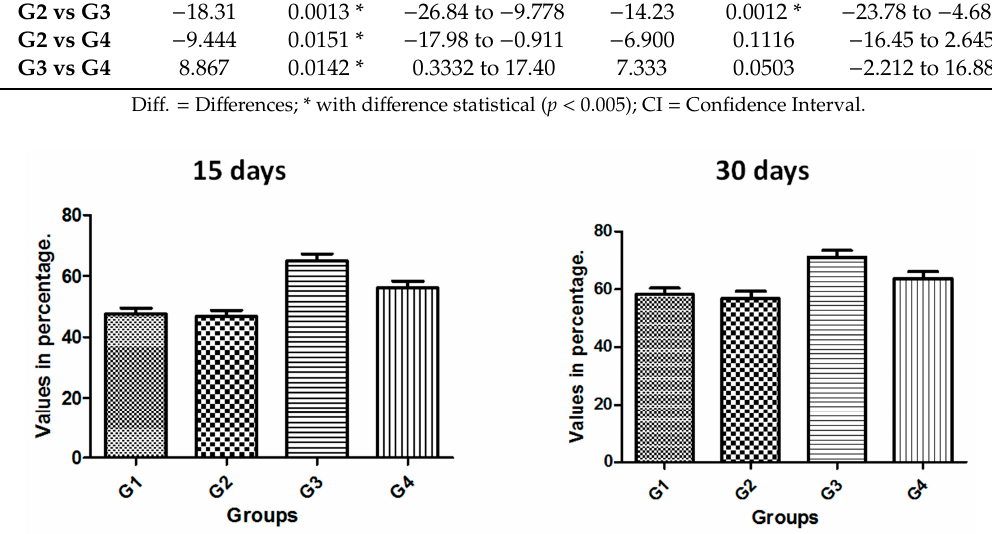
Table 8. Bonferroni’s multiple comparison test to compare the bone fraction occupancy inside the threads (BAFO%) values between the groups.